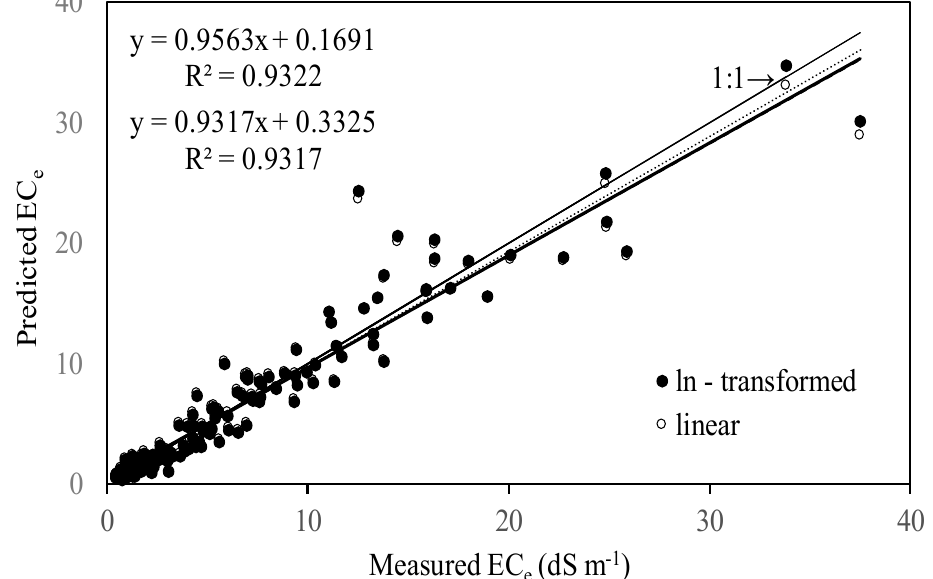
Figure 5. The relationship between measured values of EC e and the estimated EC e from the ln- transformed model (Pred EC e = 0.9563EC e + 0.1691) and the linear expression Pred EC e = 0.9319EC e +